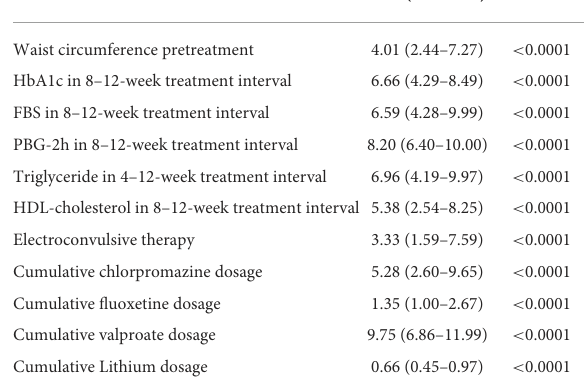
TABLE 4B Multivariate analysis of risk factors for cognitive impairment in patients with BP.